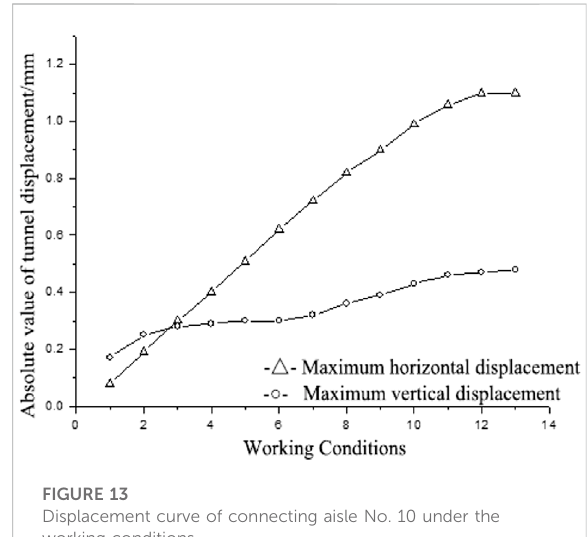
FIGURE 12 Displacement curve of connecting aisle No. 9 under the working.